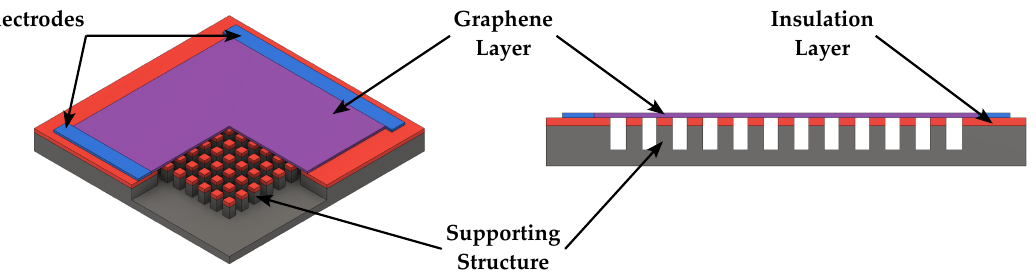
Figure 8. Schematic 3D view and cross section of a thermoacoustic